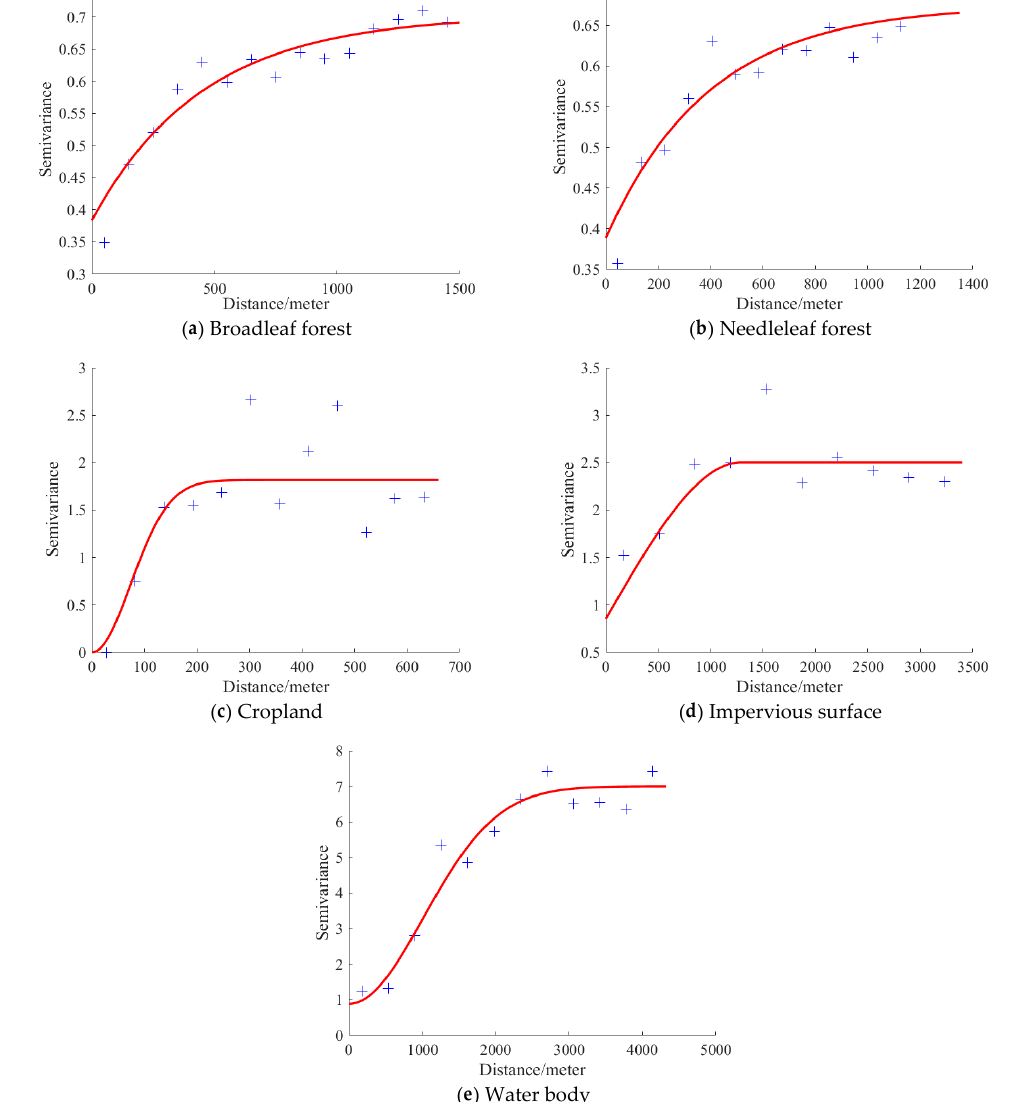
Figure A2. Variogram Diagrams of Di ff erent Land Cover Types in 2020.